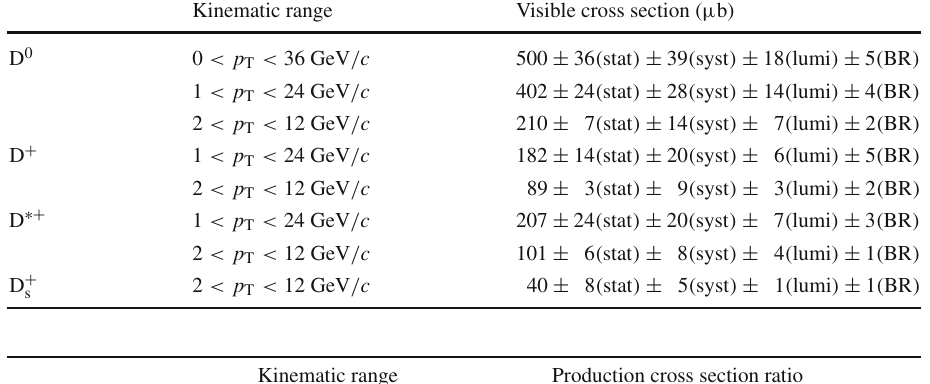
T -integrated cross sections of prompt D mesons in | y | < 0 . 5 √ s = 7 TeV in pp collisions at